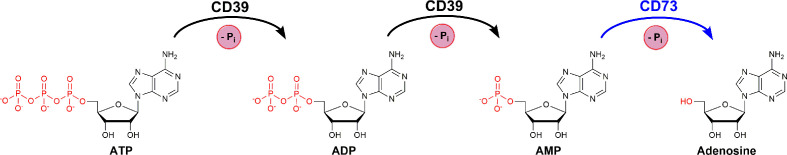
Consecutive hydrolysis of ATP to adenosine by cleaving the terminal phosphate group and releasing inorganic phosphate (Pi), catalyzed by the enzymes CD39 and CD73.